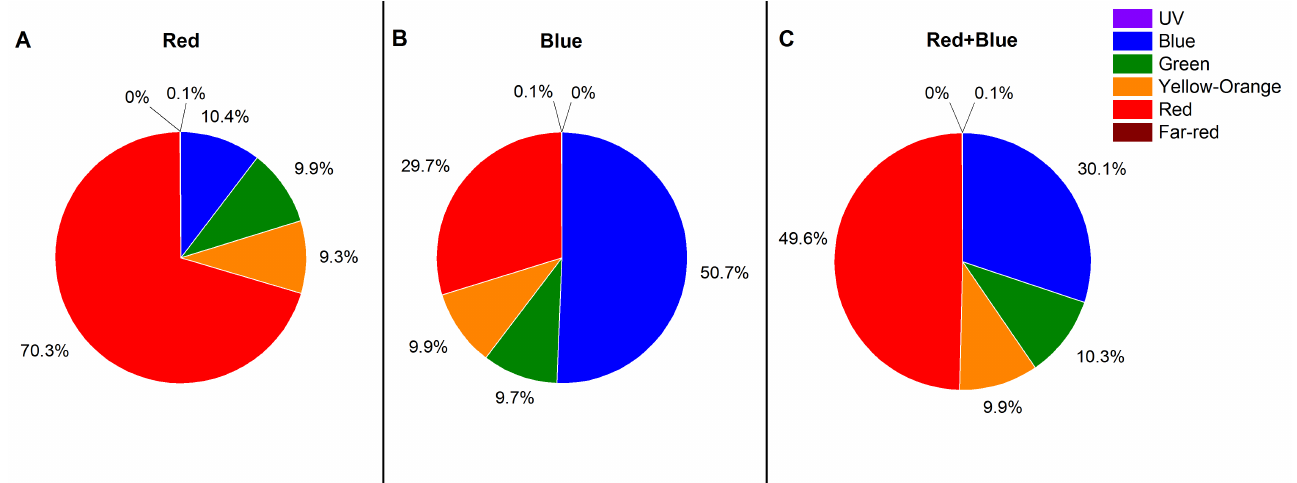
Figure 1. The characteristic of light